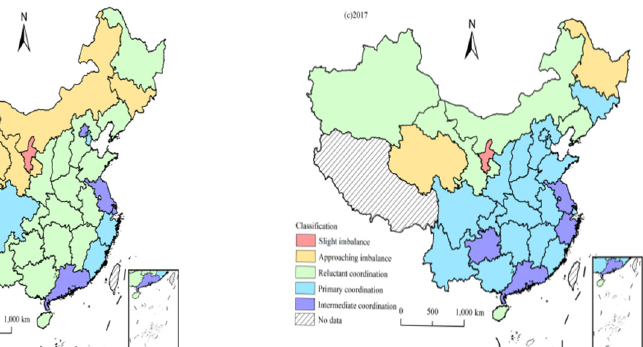
Figure 5. The spatial distribution of the coupling coordination degree of 30 provinces.